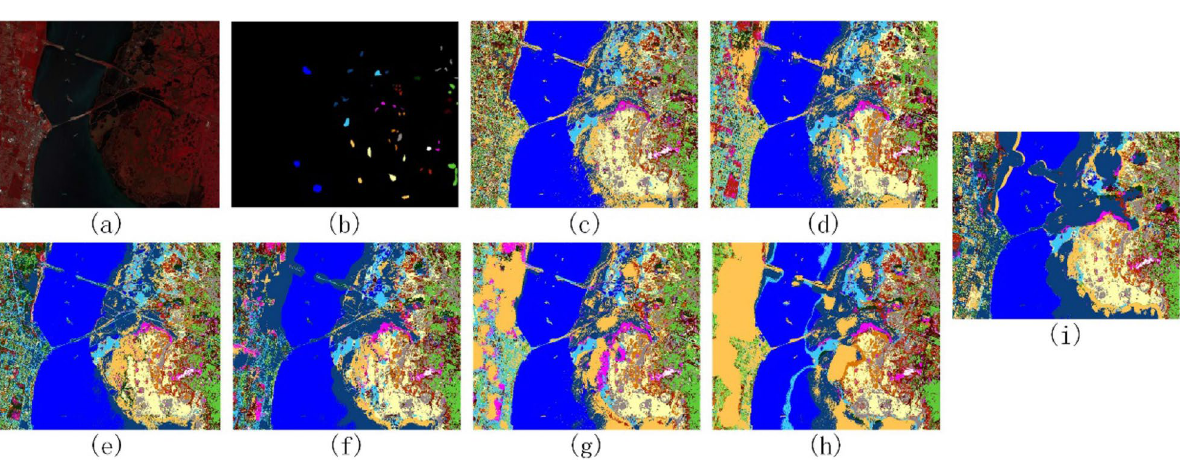
Figure 10. Kennedy Space Center data classification results. ( a ) False-color map; ( b ) Ground-truth map; ( c ) PCA; ( d ) EMP; ( e ) SAE; ( f ) 3D-CNN; ( g ) Gabor-Based; ( h ) RPNet; ( i )